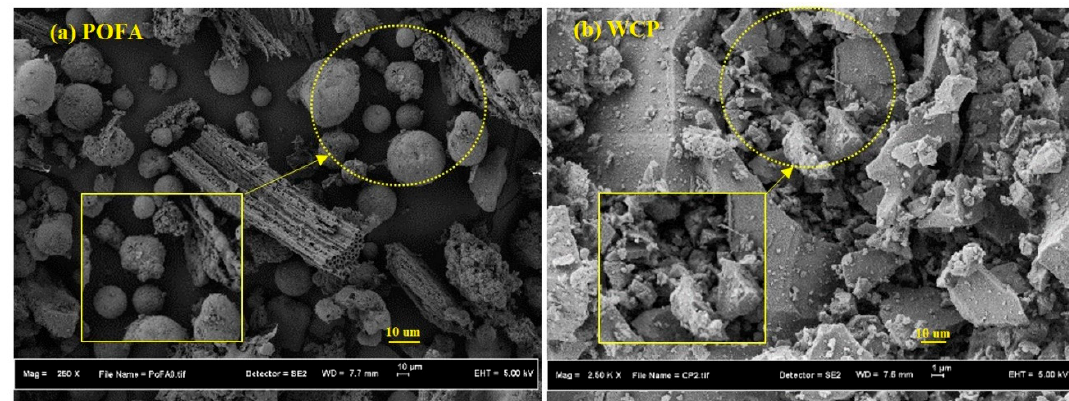
Figure 2. SEM images of ( a ) POFA and ( b ) ceramic waste.